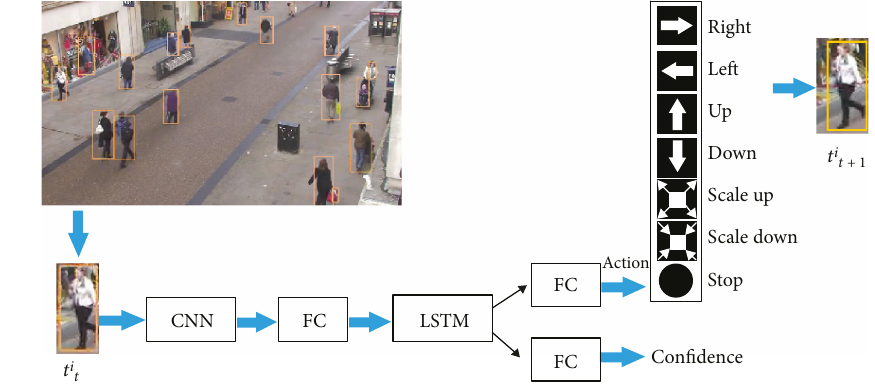
Figure 5: The pipeline of the single-object